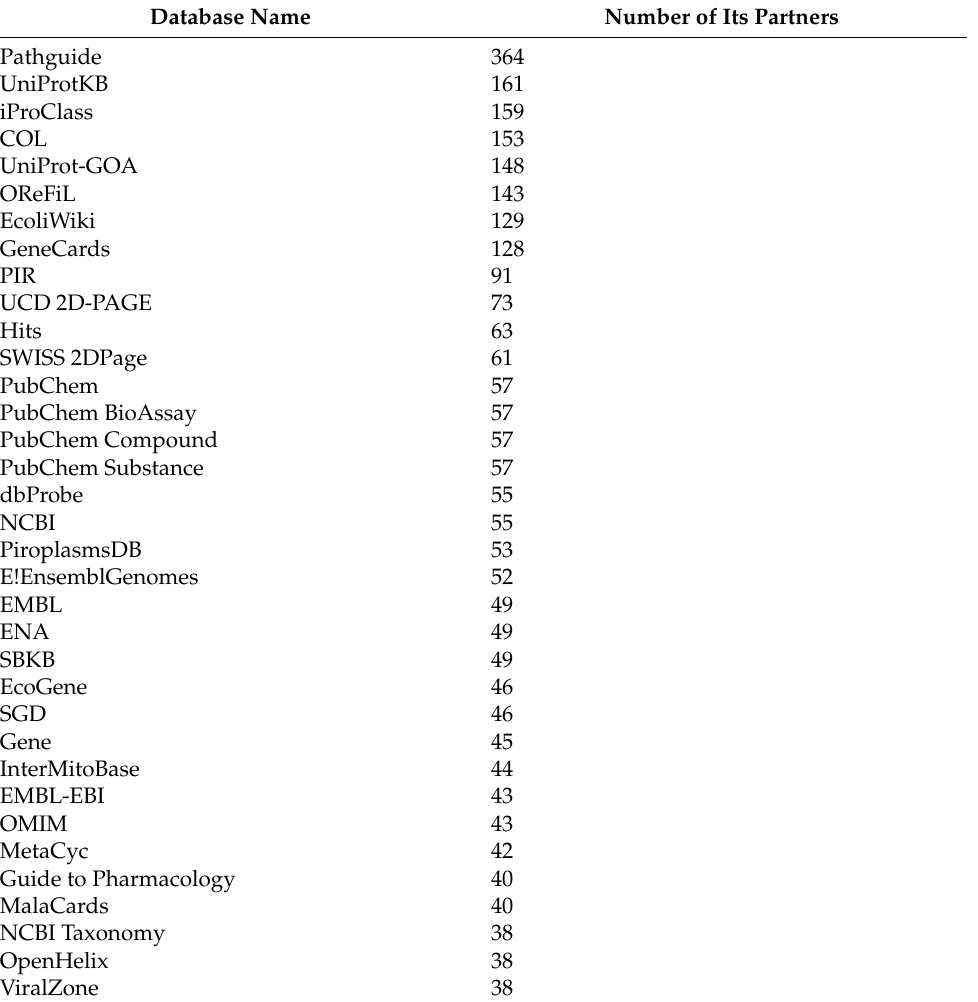
Table 2. Microbial databases with more than 37 partners (connection number—CN).